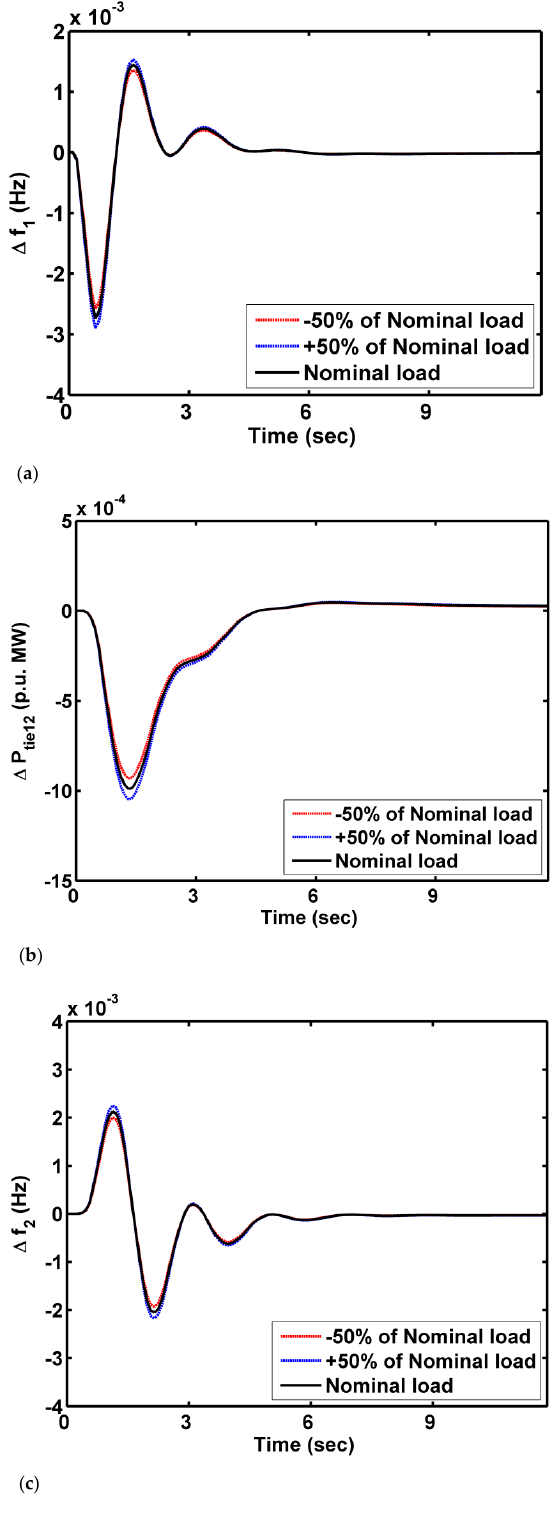
Figure 12. Responses for case 6 for load variations: ( a ) Δ f 1 ( b ) Δ P tie12 and ( c ) Δ f 2 .